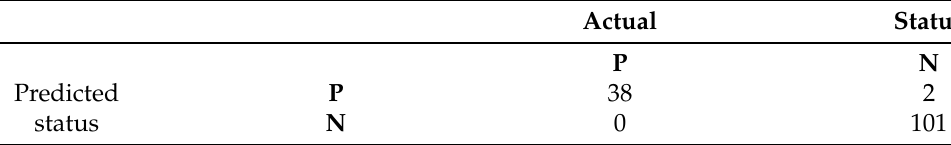
Figure 9. Graph of the capacity during the test. Table 4. Confusion Matrix of the second